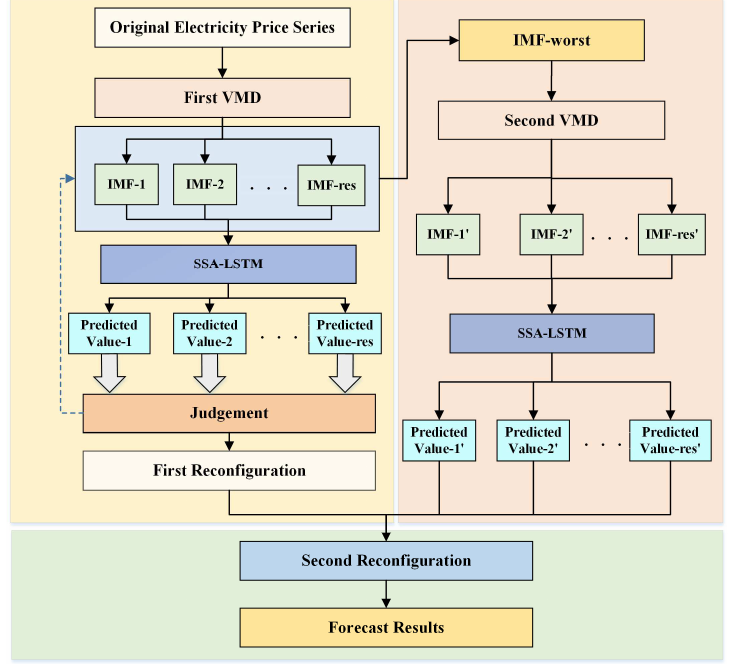
Figure 2. Block diagram of the prediction process of the VMD-SSA-LSTM model.